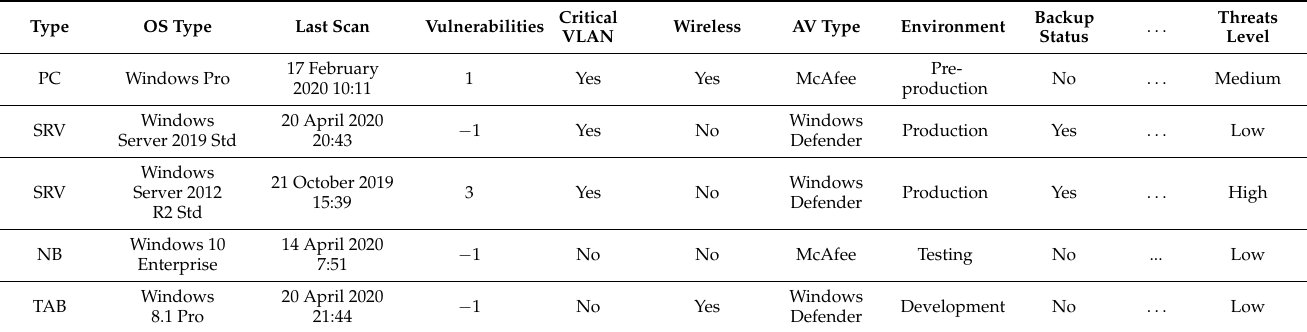
Table 3. Fragment of the training dataset.